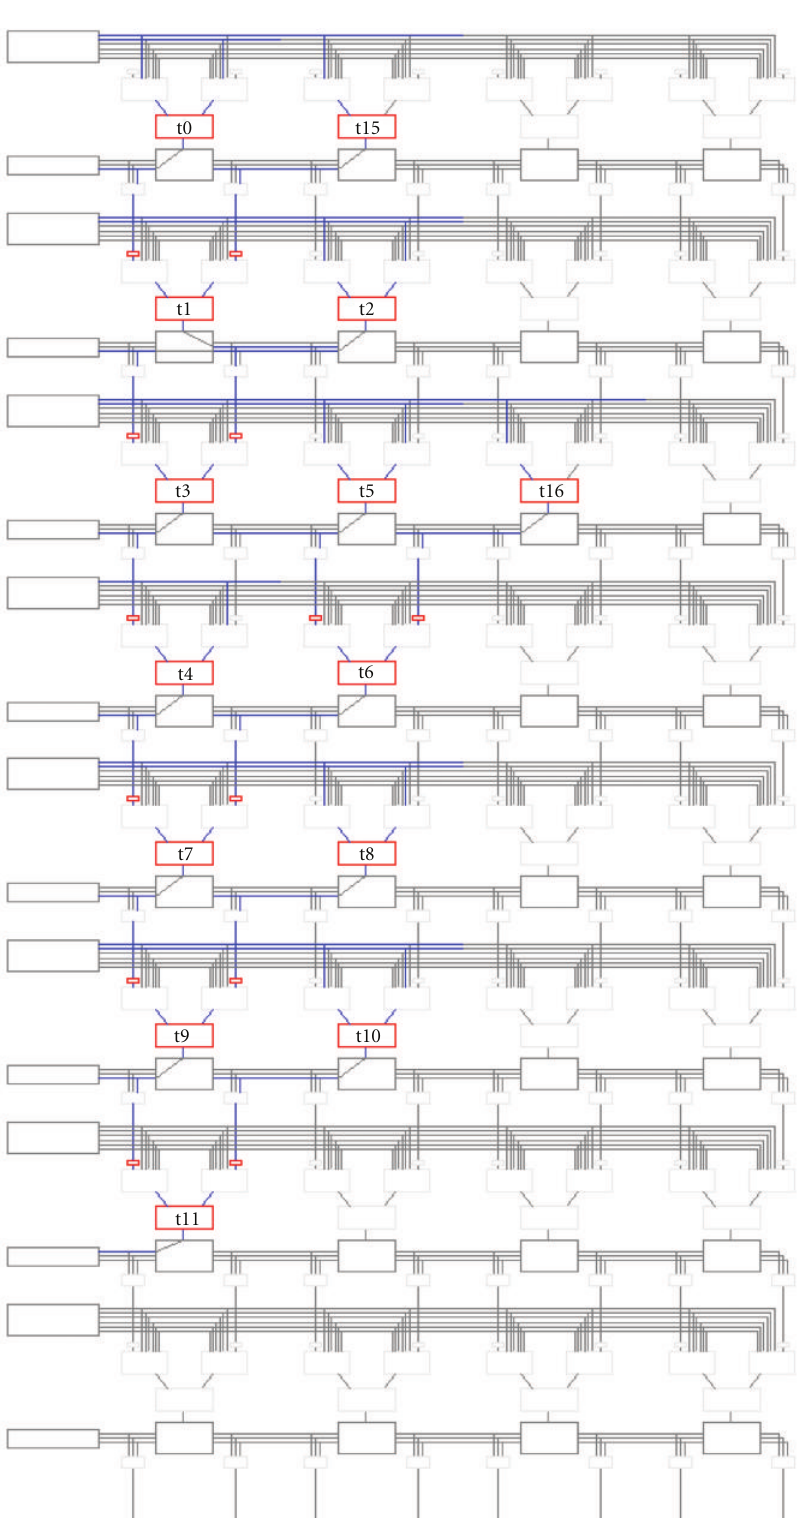
Figure 13: The view Biniou provides over a Coarse Grained Reconfigurable Architecture under